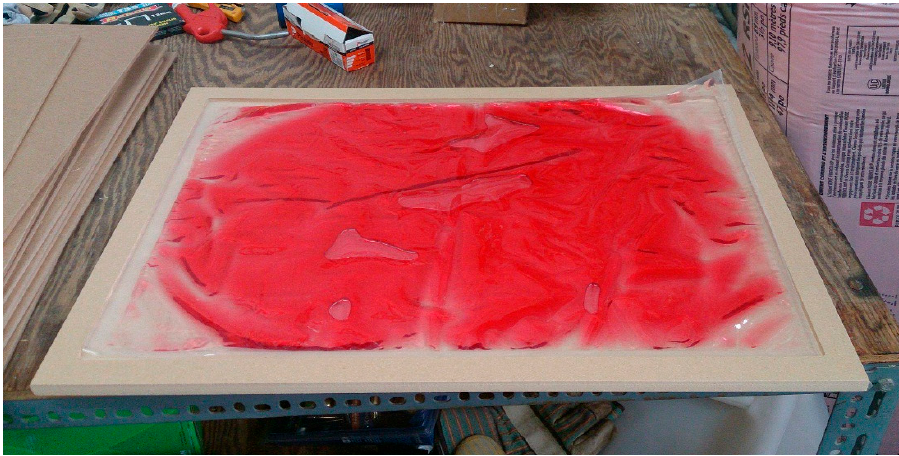
Figure 2. Pouch containing PT23 in a grooved MDF panel.